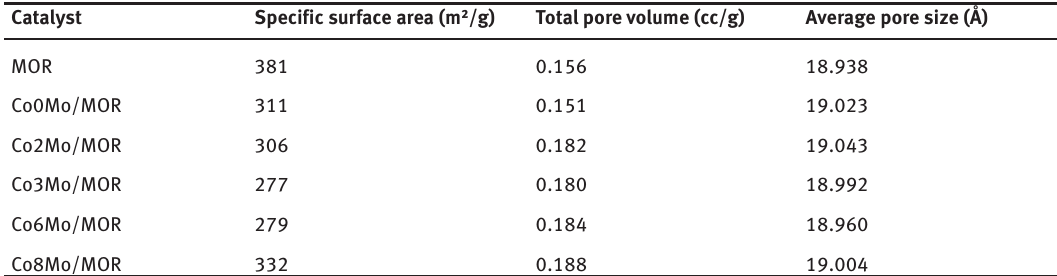
Figure 8: Morphology of MOR and CoMo/MOR Table 4: The parameters of porous structure of MOR and CoMo/MOR catalysts.